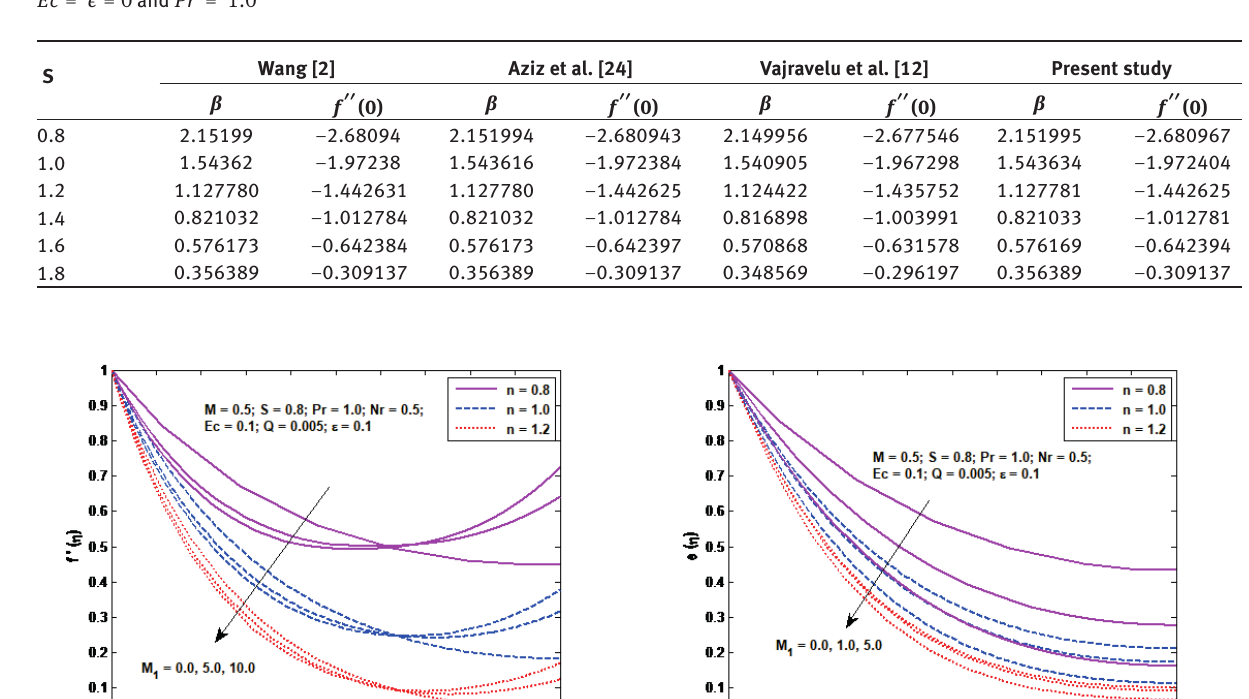
the film. Increasing values of magnetic field strength fur- ther decrease velocity. This behaviour can be attributed to the resistive nature of Lorentz force induced as a result of a transverse magnetic field. This reduction is more promi- fluid types. In shear thickening fluids, the decrease in